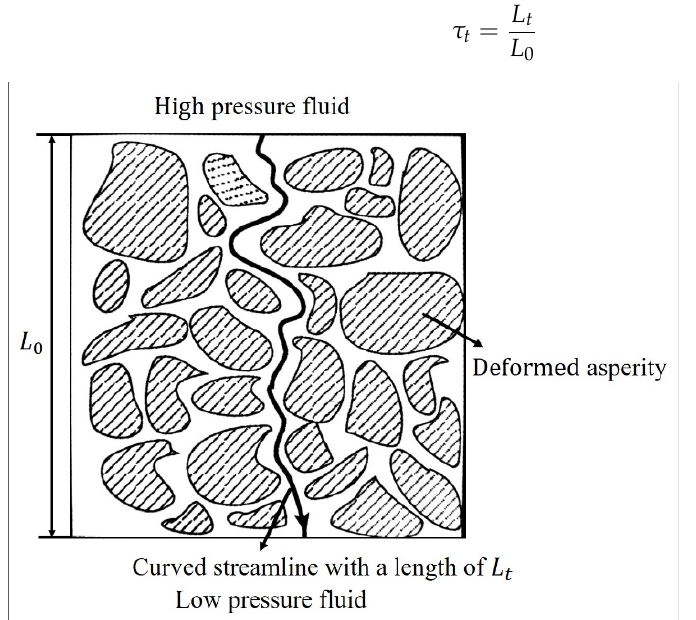
Figure 8. Schematic diagram of the sealing medium flowing through the leakage micro-channel (capillary tube) on the sealing interface.